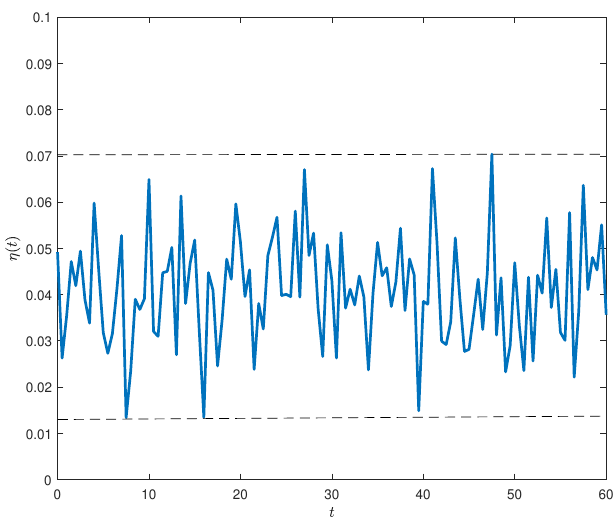
Figure 3. Optimal proportion of consumption η ( t ) as a function of t